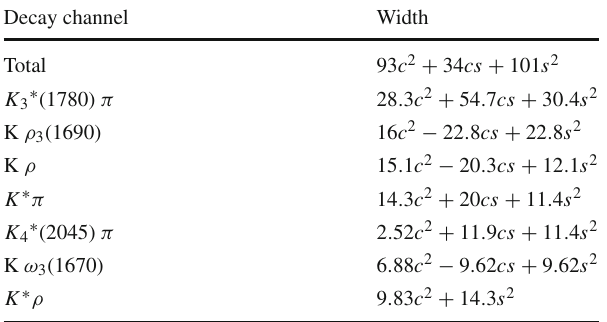
Table15 Thewidthsof(predicted) K 4 ( 2310 ) and K 4 ( 2500 ) depending ontheirmixingangle,where s and c